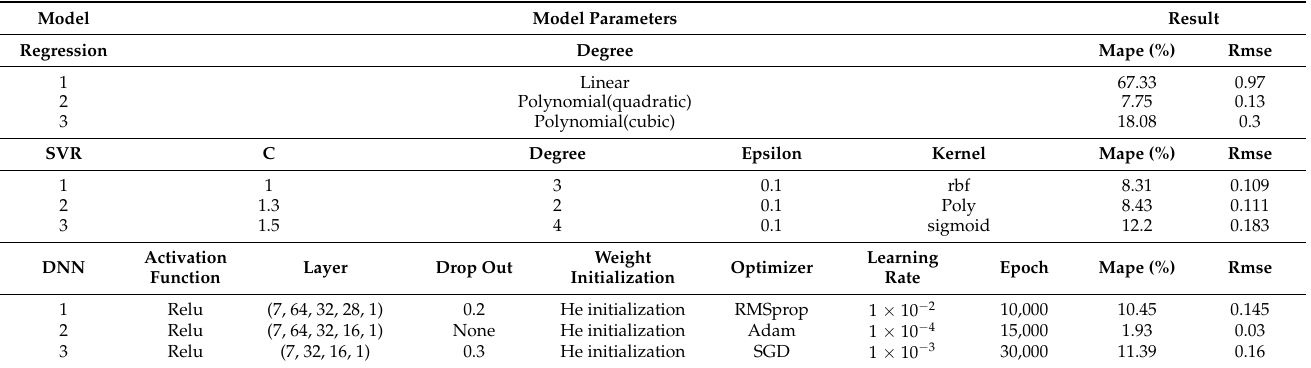
Table 5. Results of performance